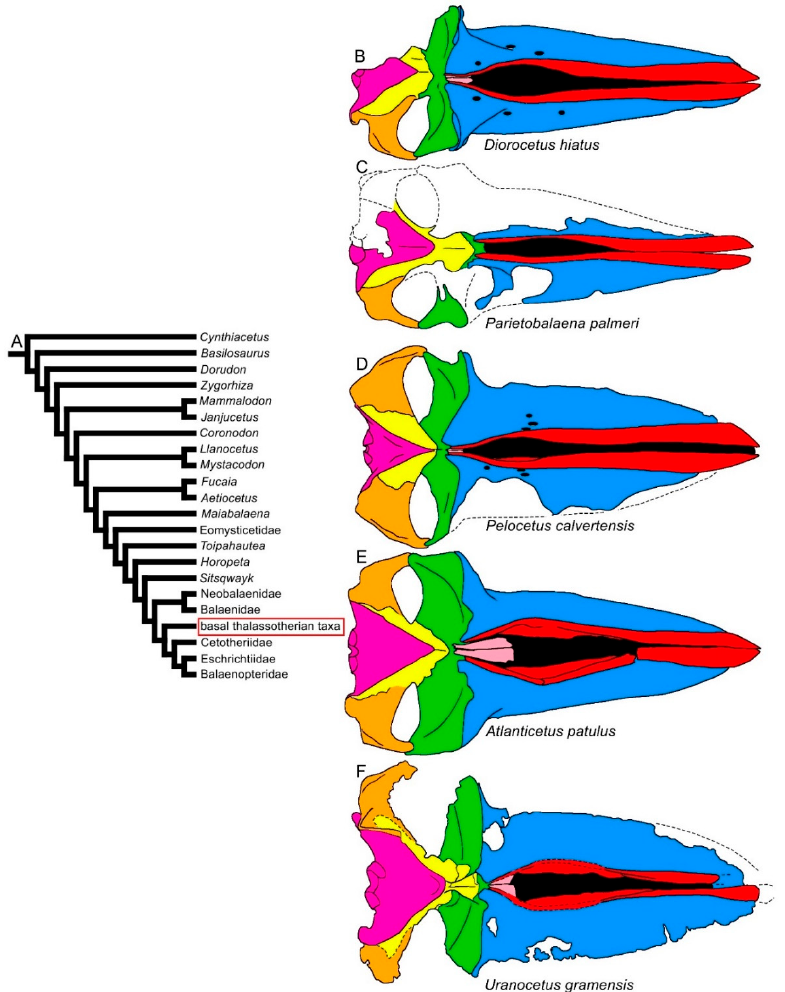
Figure 12. Diversity of balaenomorph mysticete skulls in dorsal view: basal thalassotherian taxa. ( A ) Phylogenetic relationships among mysticetes showing the branching order of the basal thalassotherian clade. ( B ) Skull of Diorocetus hiatus . ( C ) Skull of Parietobalaena palmeri (United States National Museum, Smithsonian Institution No. 10677). ( D ) Skull of Pelocetus calvertensis . ( E ) Skull of Atlanticetus patulus . ( F ) Skull of Uranocetus gramensis . Not to scale. The skulls are represented as if they shared the same condylobasal